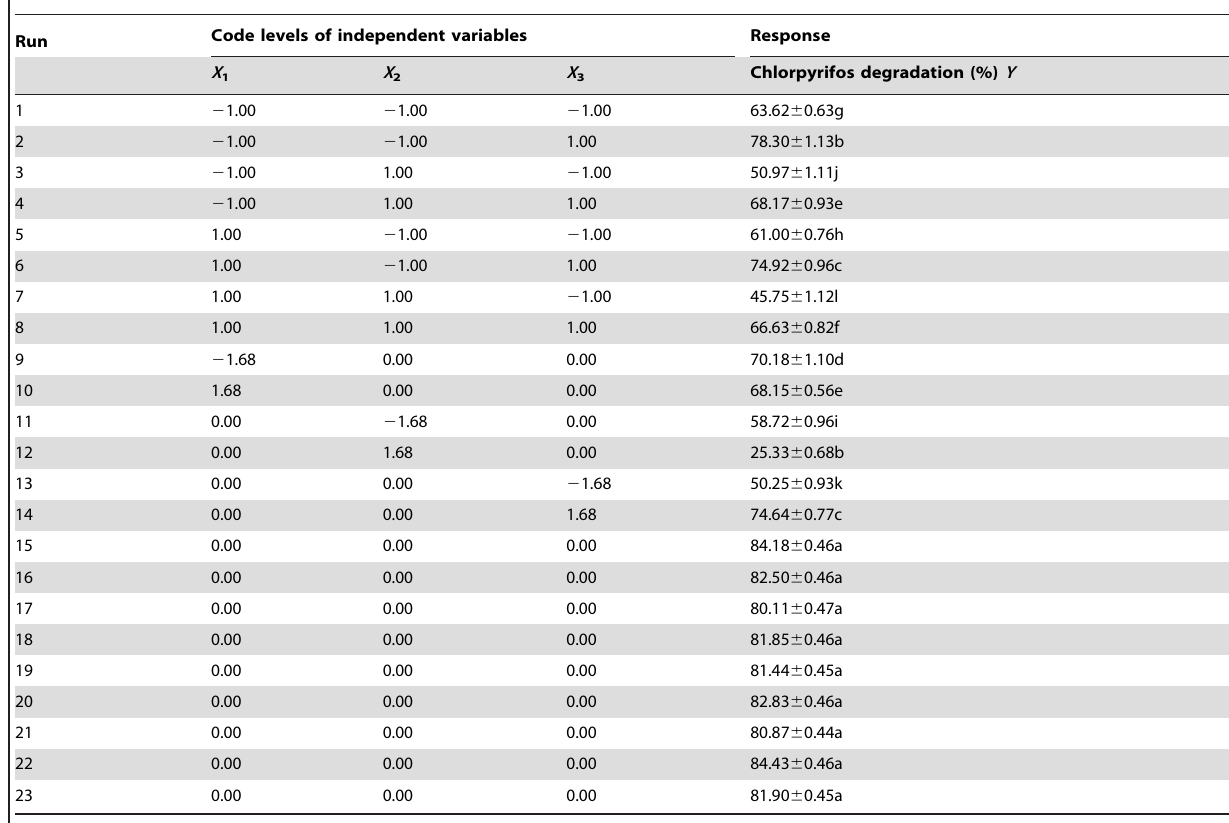
Table 2. Central composite rotatable design (CCRD) matrix and the response of dependent variable for chlorpyrifos degradation.